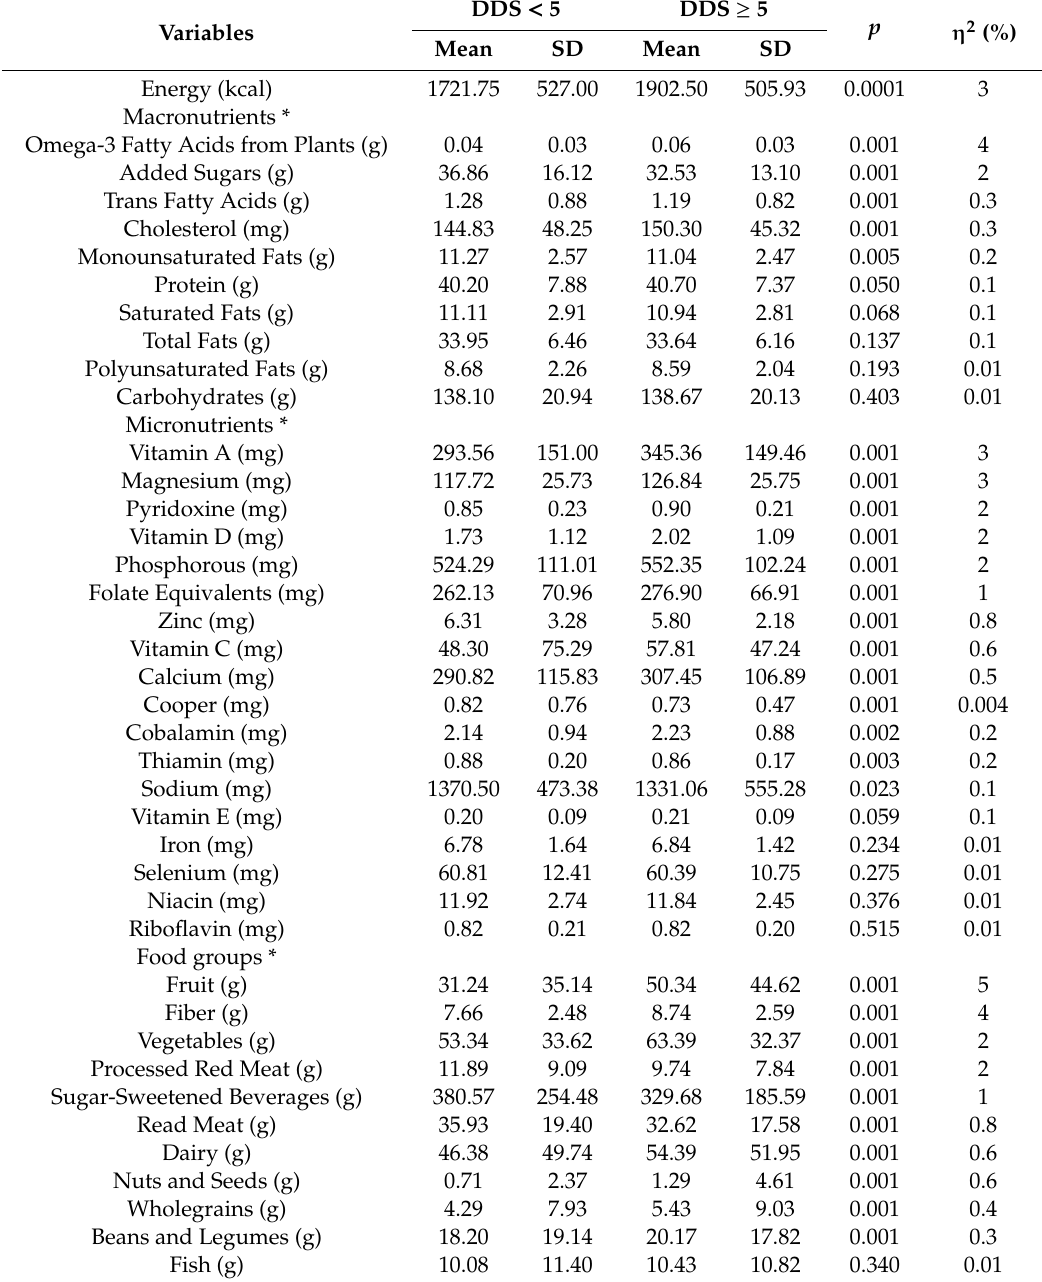
Table 3. Consumption of energy, nutrients, and food groups according to Dietary Diversity in